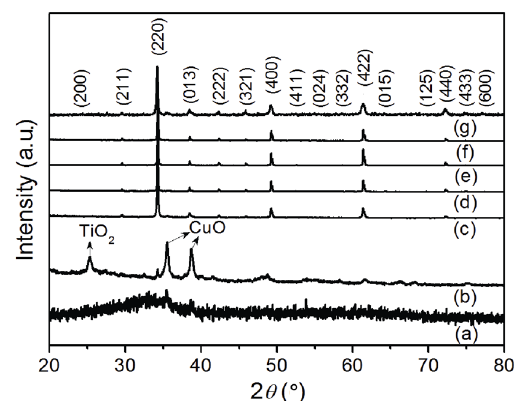
Fig. 3 X-ray diffraction patterns corresponding to the points (a) to (g) indicated in Fig. 2(a). Point (a) is related to the powder initially heat treated at 400 ℃ for 2 h. Points (b)–(e) are connected with the samples at furnace temperatures of (b) 625 ℃ , (c) 713 ℃ , (d) 950 ℃ , and (e) 955 ℃ during processing under E = 30 V·cm − 1 (current density limit of J = 42.0 mA·mm − 2 in the last case). Points (f) and (g) are related to the samples at a furnace temperature of 562 ℃ during processing under E = 200 V·cm − 1 with a current density limit of J = 22.0 and 5.0 mA·mm − 2 ,